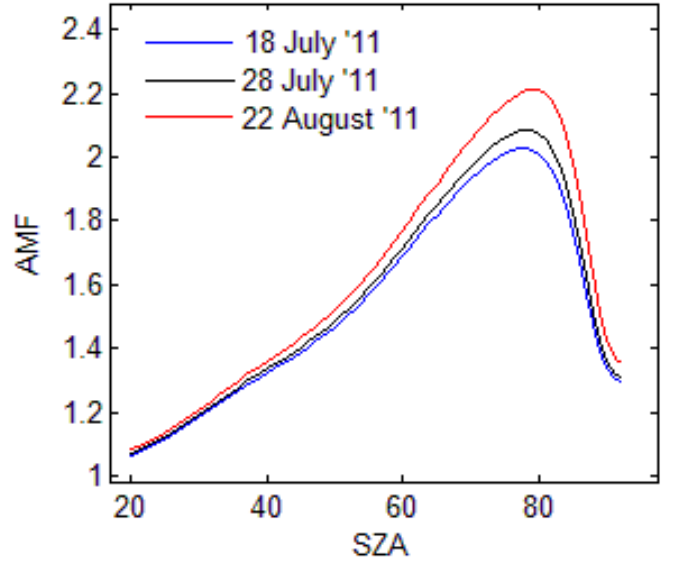
Figure 5. The tropospheric AMFs simulations for the three days of road